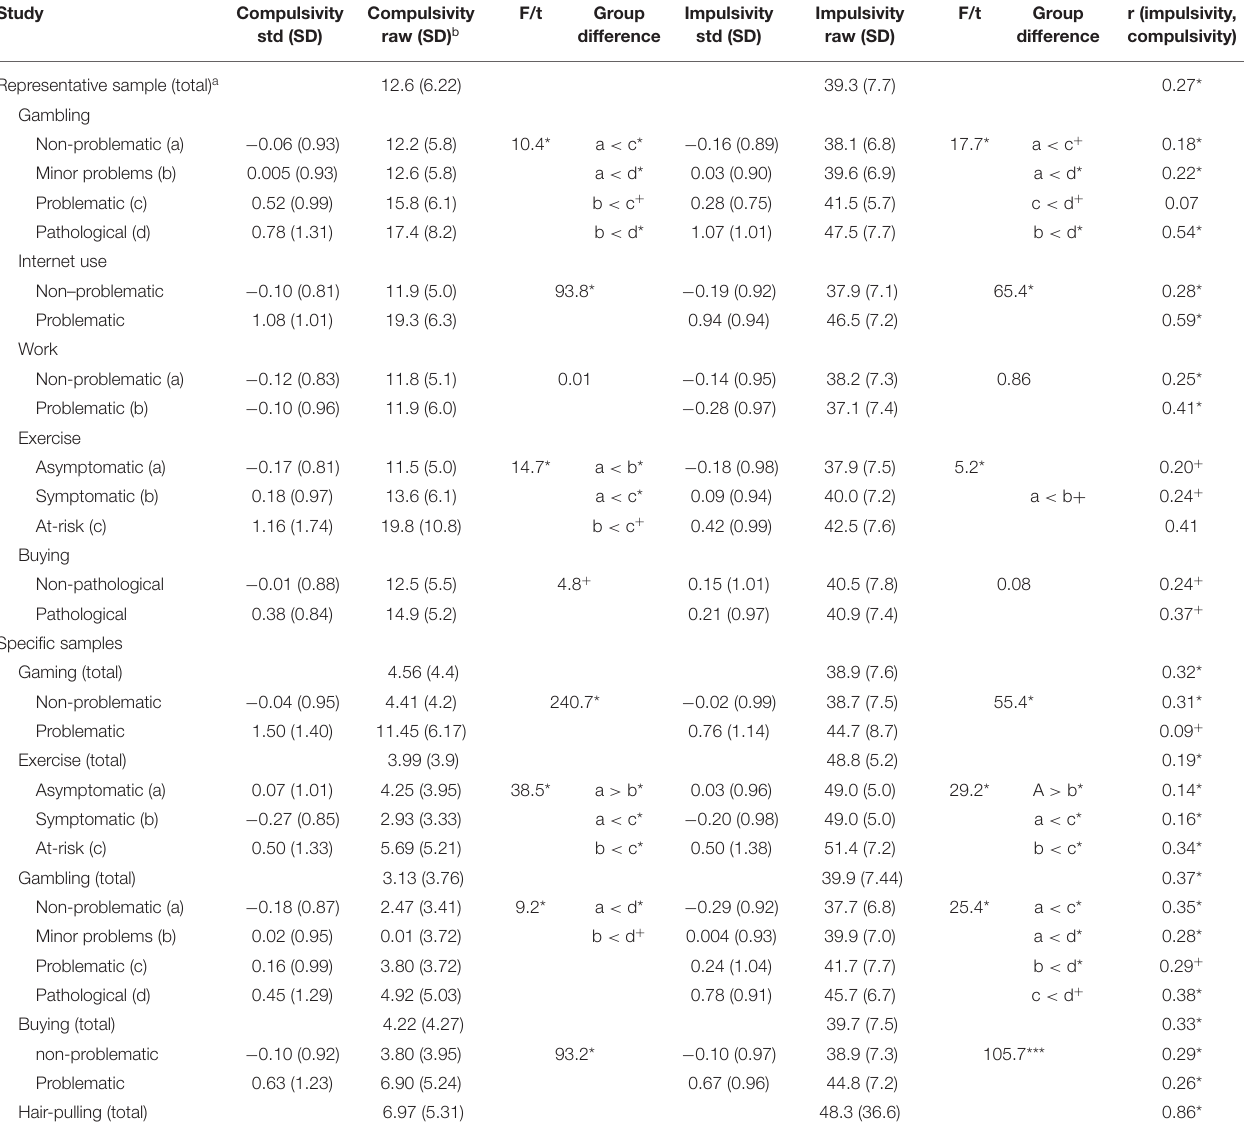
TABLE 2 | Comparison of impulsivity and compulsivity according to severity